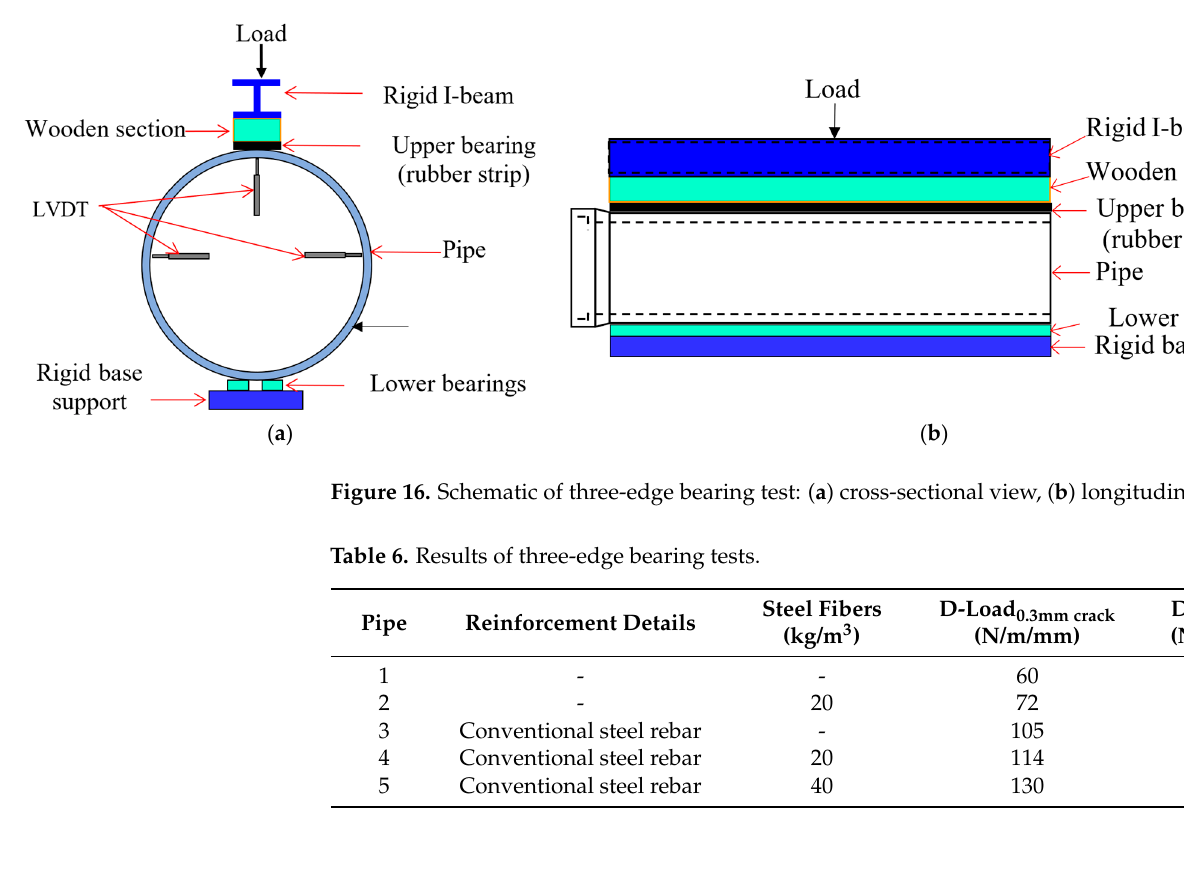
Figure 15. Setup of three ‐ edge bearing test: ( a ) side view, ( b ) 3D view.